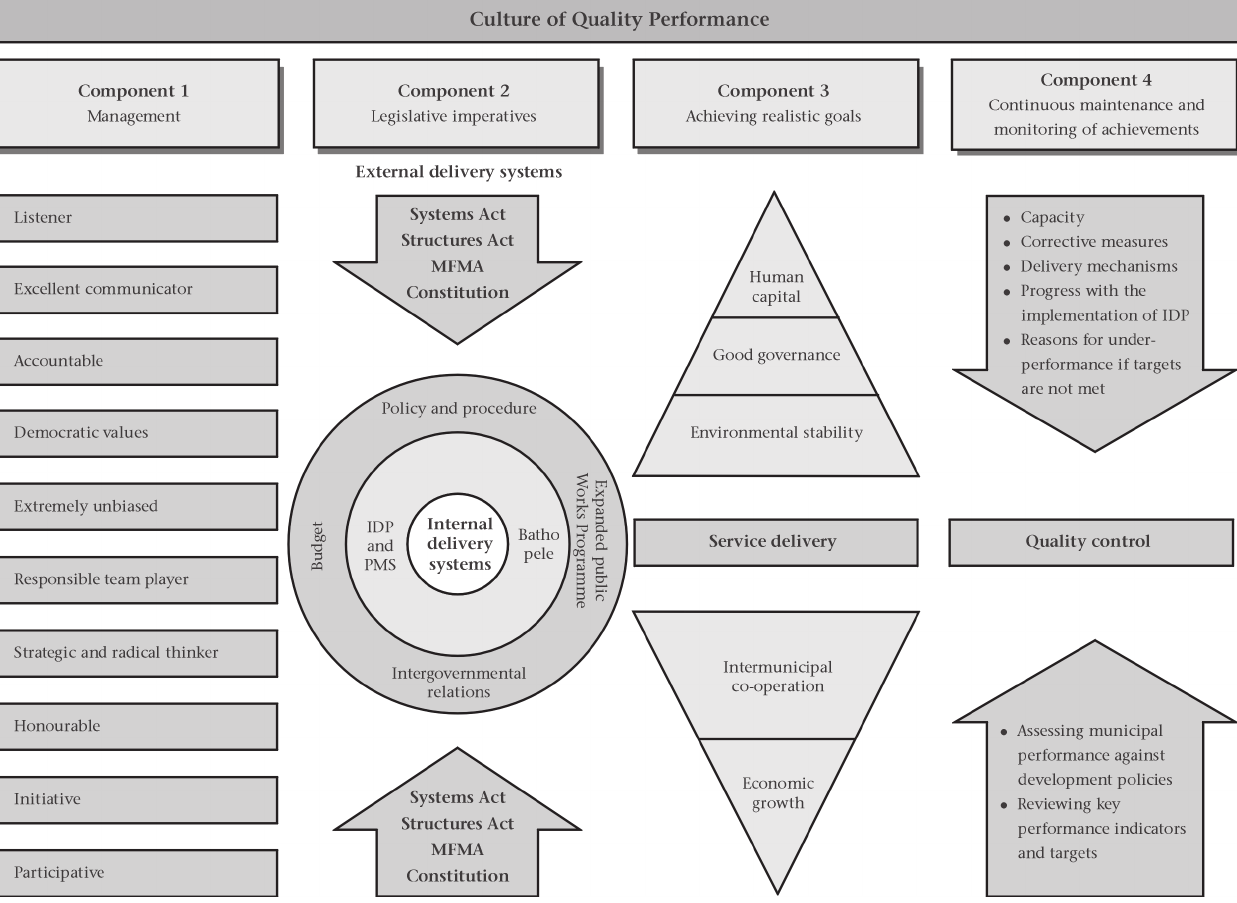
Figure 1: Retro Advanced Leadership